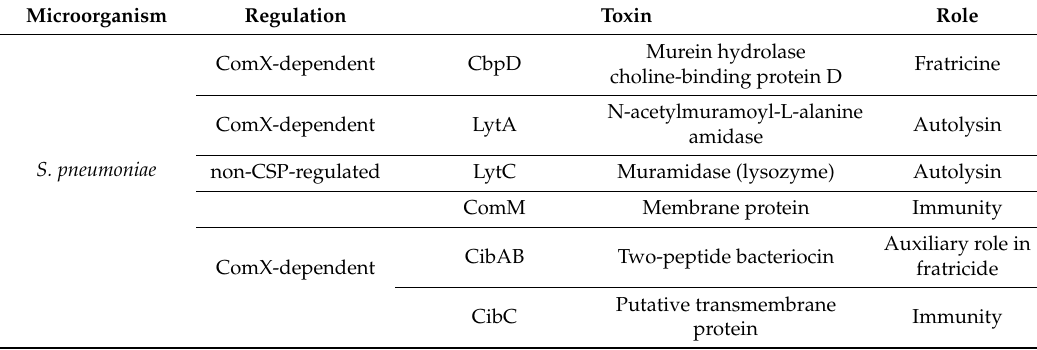
Table 1. Toxins and immunity factors in allolysis. CSP: competence-stimulating